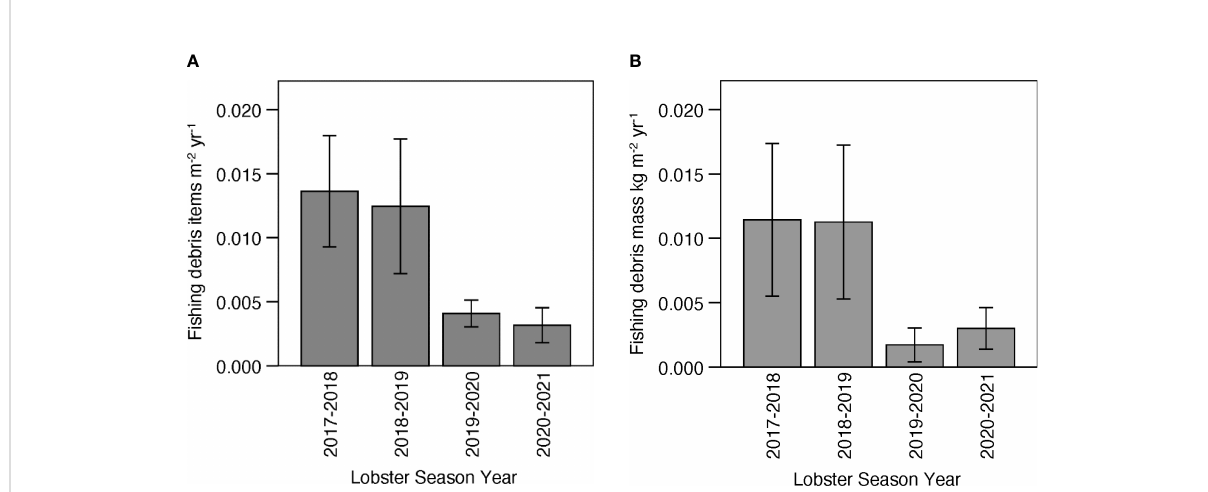
FIGURE 6 Rate of accumulation (mean ± S.E.) of lost and discarded fi shing gear items (A) and mass (B) on beaches of Santa Cruz Island, Santa Rosa Island and the California mainland during the 2017-2018 through 2020-2021 lobster fi shing